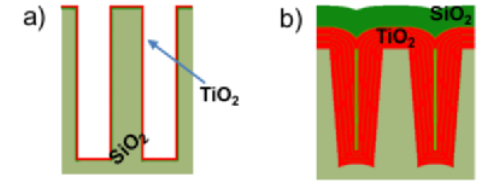
Fig. 2. a) Sketch of an ideal binary surface relief grating with conformal coating of TiO 2 . b) backfilled grating with characteristic trapezoidal shape.